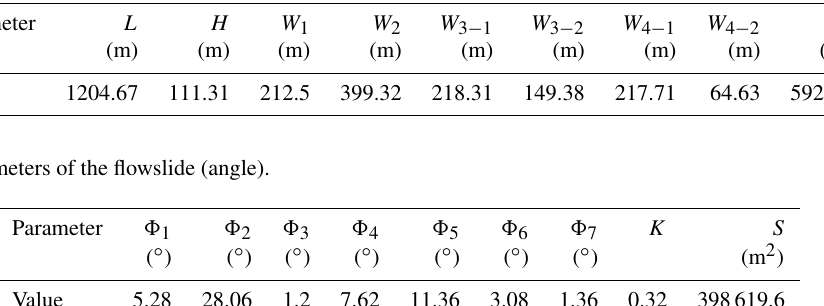
Table 1. Geometric parameters of the flowslide (length and width).